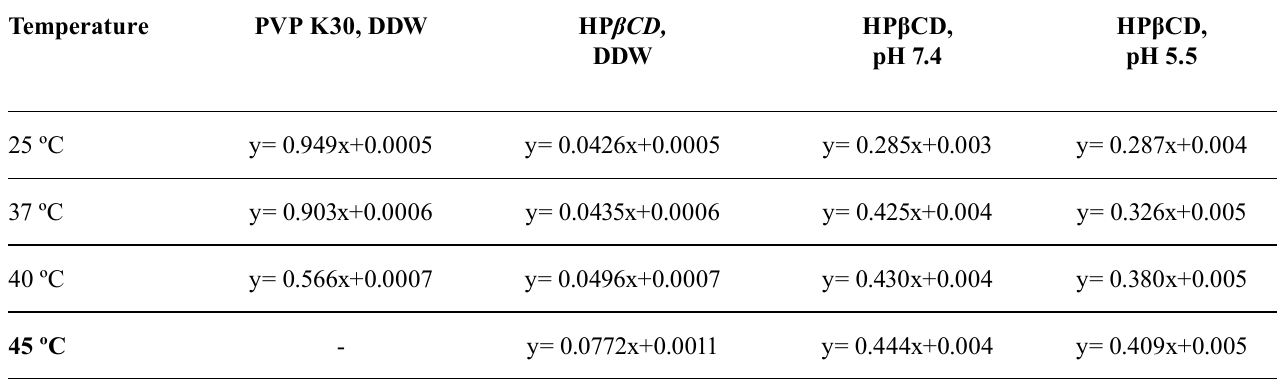
TABLE II – Equations of phase solubility profiles at different temperatures and different